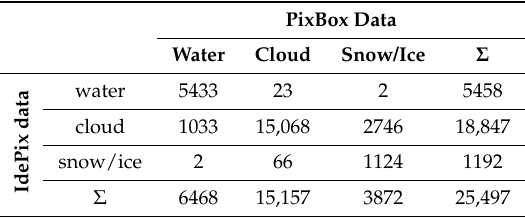
Table 3. Confusion matrix for pixel identification for